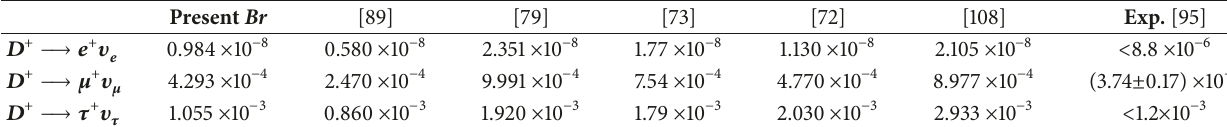
Table 13: Leptonic branching ratio of D + meson.